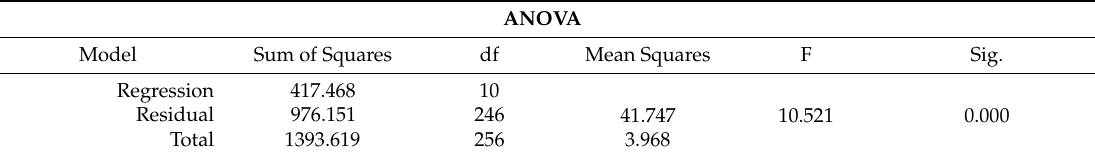
Table 8. Results of the multiple linear regression model predicting the number of reported behavior problems in domestic cats as a function of owner and household